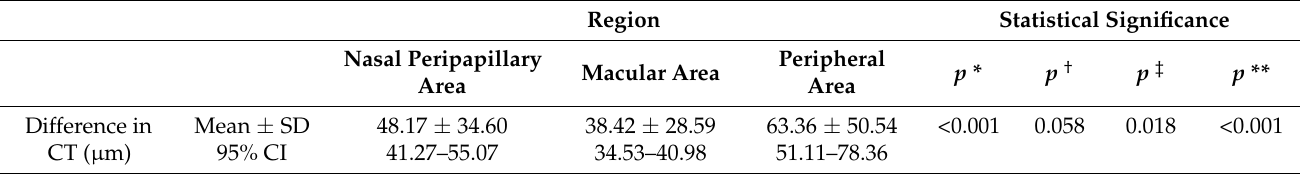
Table 4. Interocular difference in CT among the nasal peripapillary, macular, and peripheral areas. Region Statistical Significance Nasal Peripapillary Area